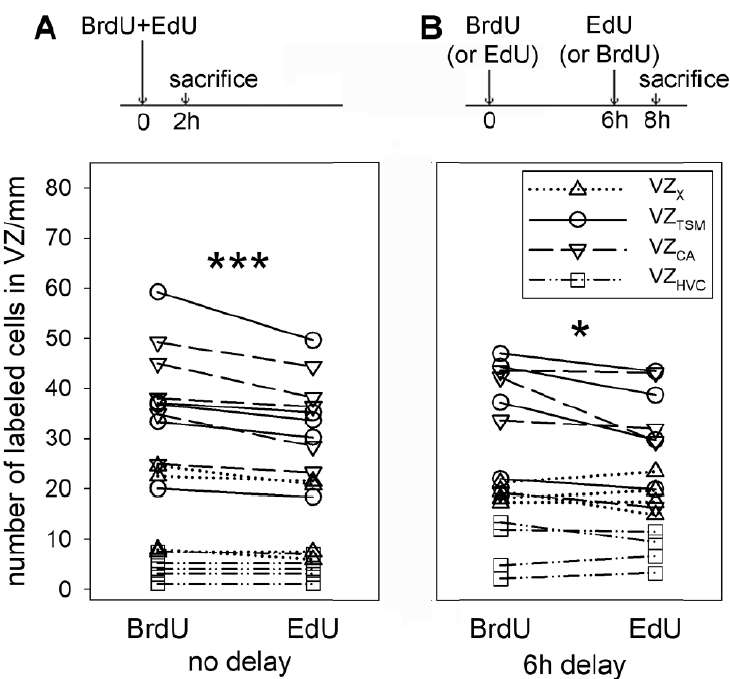
Figure 5. Scheme of BrdU and EdU injections and quantification of labelled cells in VZ of the same birds. Five birds in ( A ) received BrdU and EdU at the same time. Two birds in ( B ) received BrdU and 6 h later EdU, 2 other birds received EdU and 6 h later BrdU. Each line in the graphs connects the values from the same animal. The same symbol/line represents values obtained in VZ X , VZ TSM , VZ CA , or VZ HVC . BrdU labeled more cells than EdU. * represents p < 0.05, *** represents p < 0.001, paired t -tests.